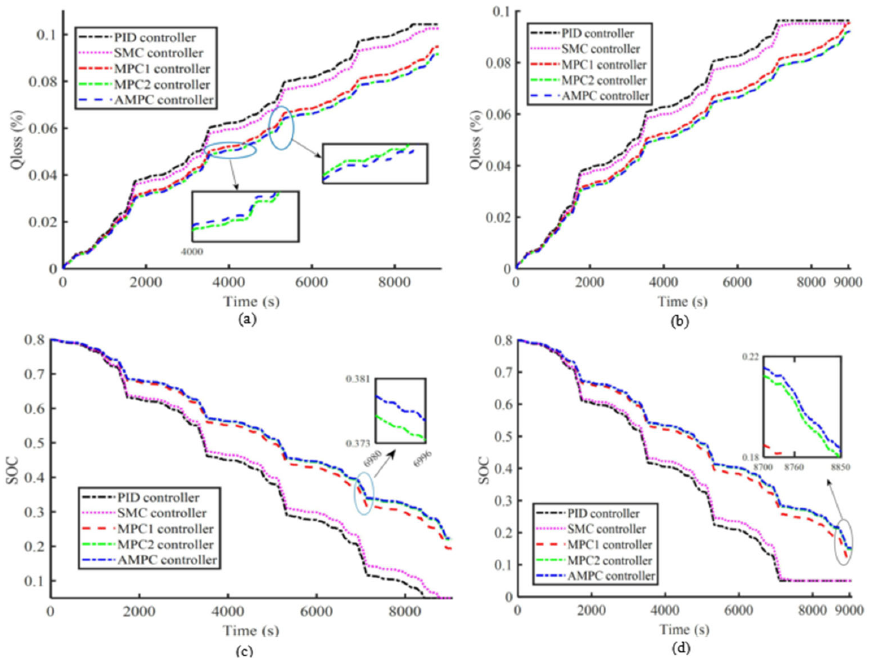
Figure 15. Under 5 WLTCs, the battery parameters under the action of each controller: when SOH = 1, ( a ) battery capacity loss ( c ) SOC. When SOH = 0.9, ( b ) battery capacity loss ( d ) SOC.